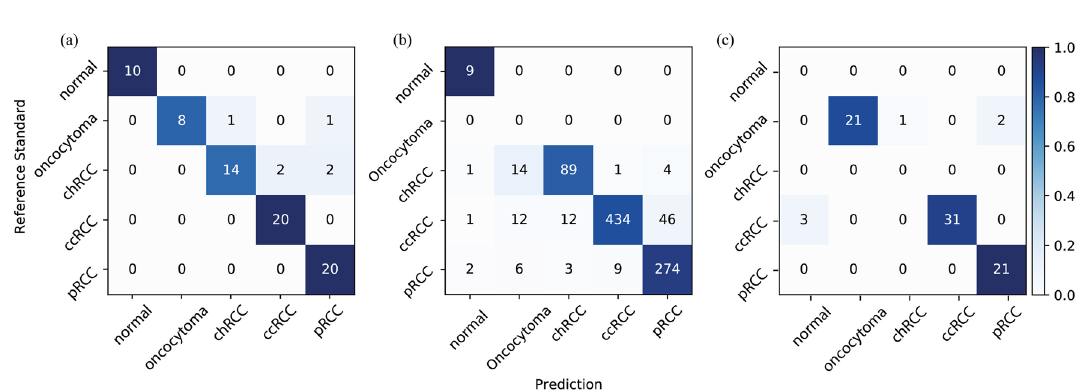
Figure 1. Each confusion matrix compares the classification agreement of our model with pathologists’ consensus for each of our three test sets: ( a ) surgical resection whole-slide images from DHMC, ( b ) surgical resection whole-slide images from TCGA, and ( c ) biopsy whole-slide images from DHMC.